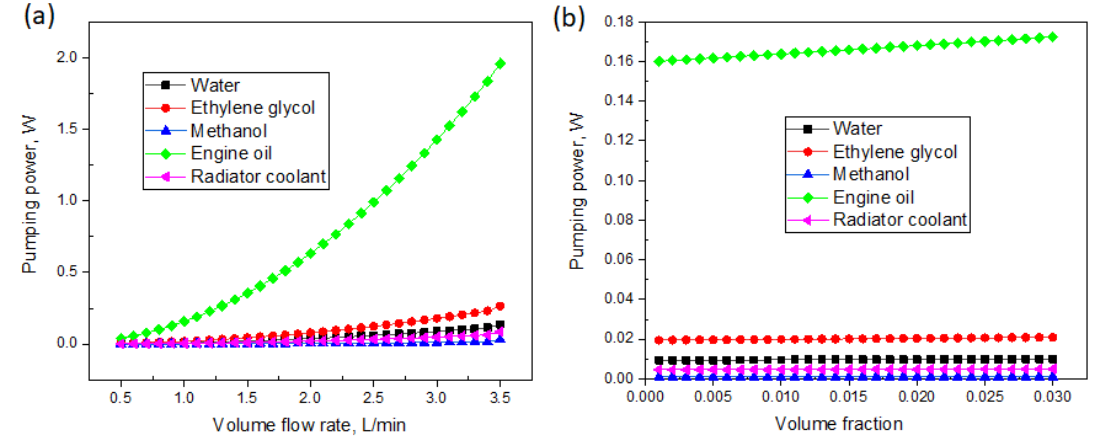
Figure 4. Variation of pumping power with ( a ) volume flow rate and ( b ) volume fraction.